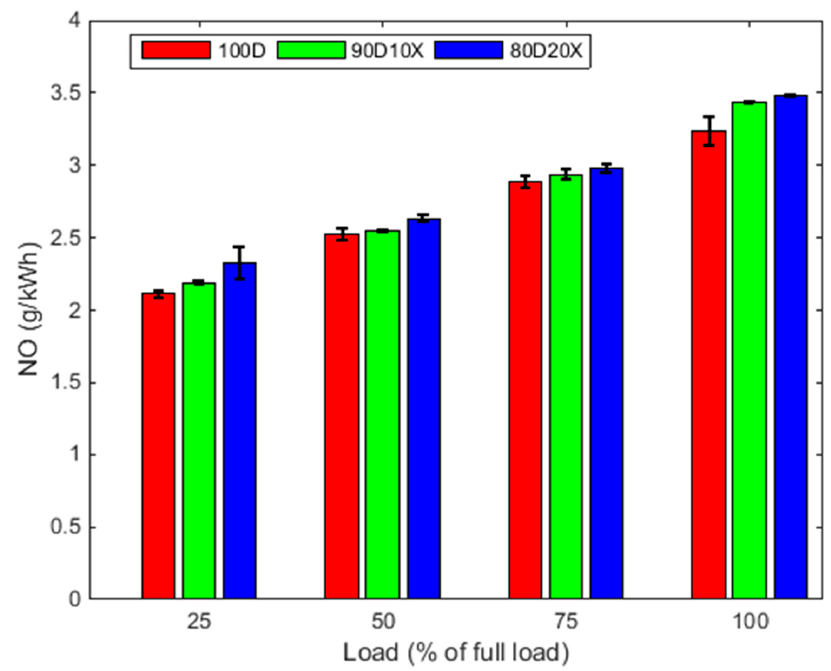
Figure 6. Brake specific NO emission with engine loads for diesel and DOP blends.